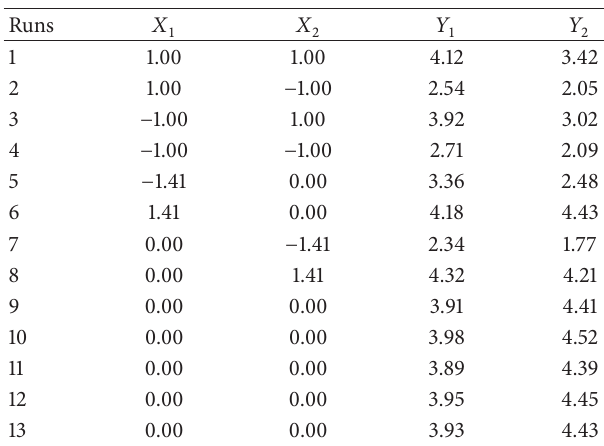
Table 3: The design matrix in coded values of the